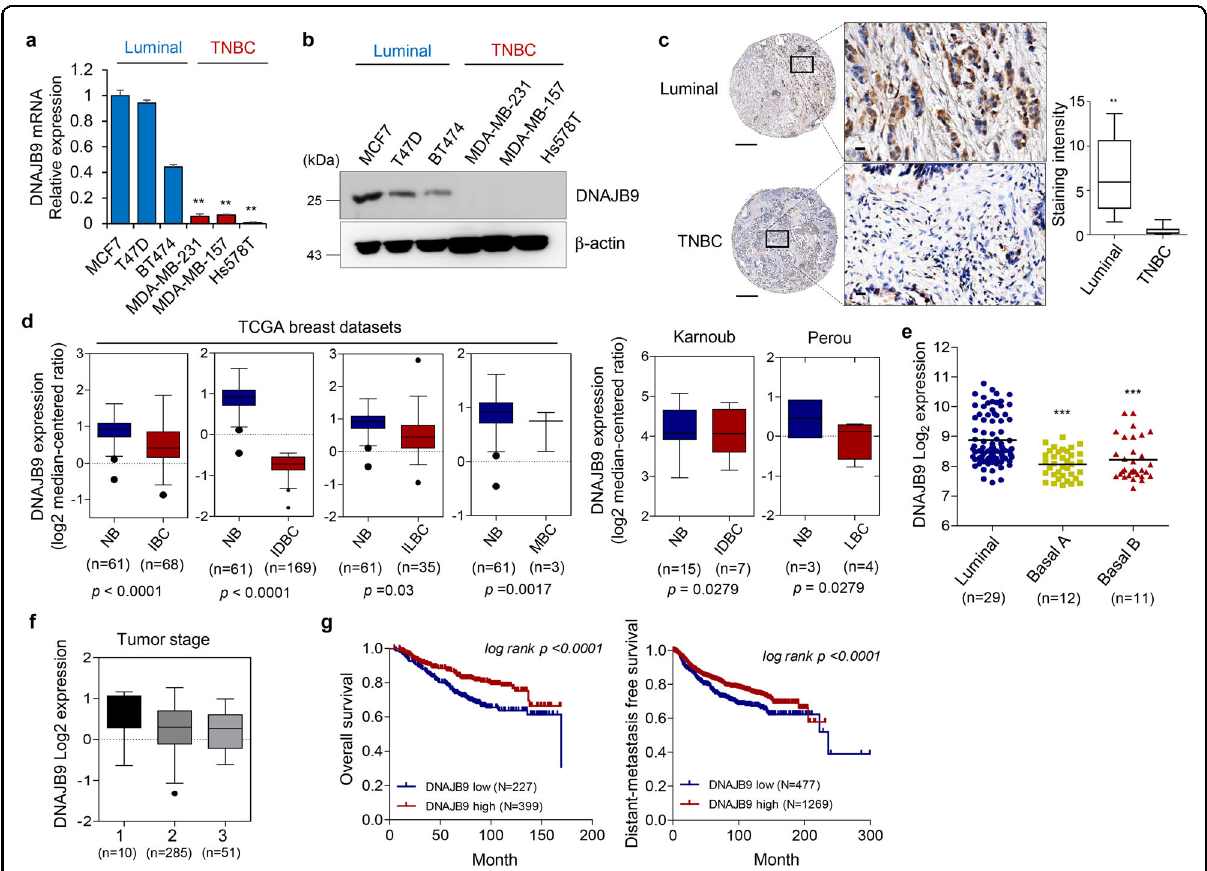
Fig. 1 Low expression of DNAJB9 in TNBC is correlated with poor clinical outcomes. a , b To con fi rm the expression of DNAJB9 at mRNA and protein levels, total RNAs and proteins were extracted from luminal and TNBC cell lines. Then the expression levels of DNAJB9 were determined using qRT – PCR or western blotting. Cyclophilin and β -actin were detected as normalization controls, respectively. c Representative immunohistochemical staining images of DNAJB9 in 26 cases of paraf fi n-embedded human breast cancer specimens. Images were quanti fi ed using ImageJ from at least three fi elds. Scale bar, 100 μ m. Staining intensity was compared between luminal and TNBC cells. d Box plots of DNAJB9 mRNA in different subtypes of breast cancer and normal tissues obtained from the Oncomine public dataset. NB normal breast, IBC invasive breast cancer, IDBC invasive ductal breast cancer, ILBC invasive lobular breast cancer, MBC mucinous breast cancer, LBC lobular breast cancer. e Scatter dot plots of DNAJB9 mRNA transcript levels in a panel of 52 breast cancer cell lines using public microarray datasets. f DNAJB9 mRNA expression in breast tumors strati fi ed based on the tumor stage using the Oncomine public dataset. g Kaplan – Meier analysis of the OS and DMFS of patients with breast cancer. Patients with tumors expressing DNAJB9 at levels higher than the mean value are labeled in red, whereas those with tumors with gene expression levels below the mean are shown in blue. P values were calculated using log-rank Mantel – Cox test. All p values were calculated using unpaired two-tailed Student ’ s t tests ( a , c ). Results are presented as mean ± standard deviation from three independent experiments. ** p < 0.01; *** p <